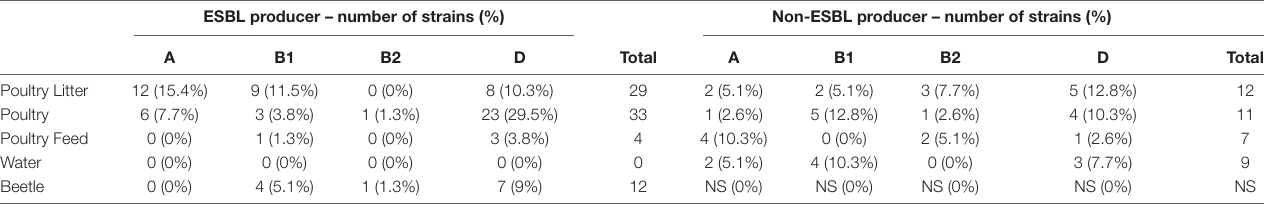
TABLE 4 | Phylogenetic distribution of 78 ESBL-producing E. coli strains and 39 non-ESBL-producing E. coli strains based on the isolate source. ESBL producer – number of strains